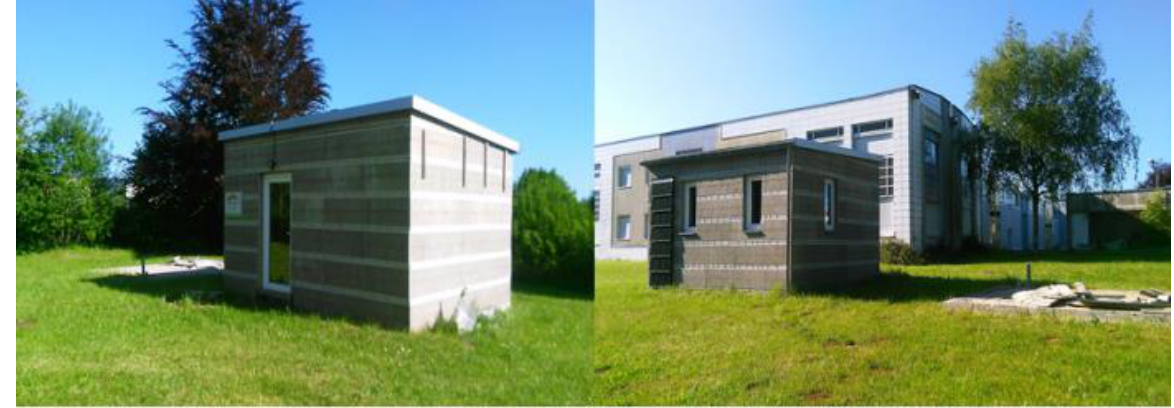
Figure 3. The eco-cottage building on the Longwy site. (Lorraine University, North East of France, 300 m above the sea level, 49.52 ◦ N and 5.769 ◦ E). The building plans are given in Appendix